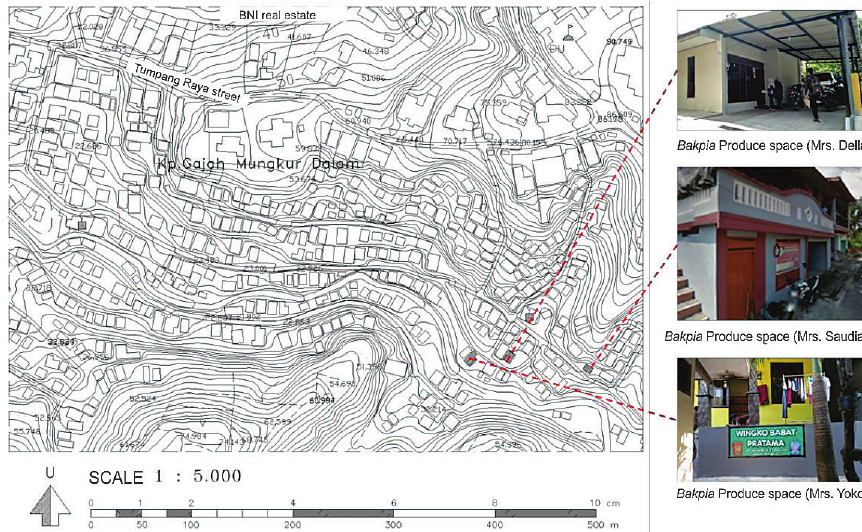
Figure 2. Location of “Jajan Pasar” (traditional snack) Production House in hamlet IX Gajahmungkur Administrative Village